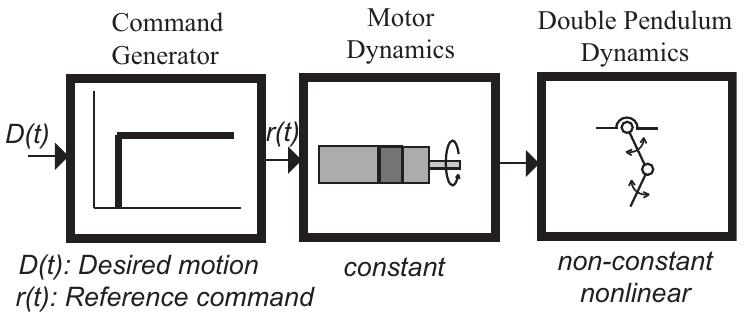
Figure 17. Block diagram of the generic control